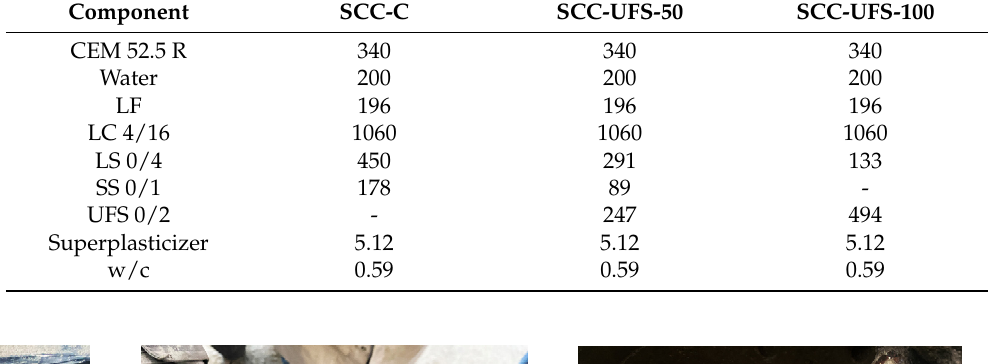
Table 3. Mix proportions (kg/m 3 ).